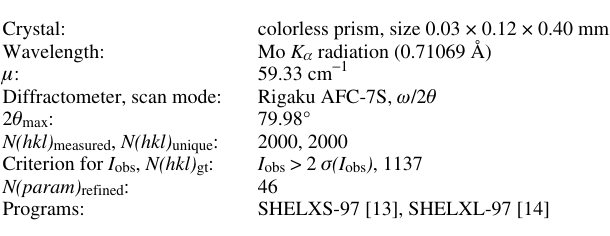
Table 1. Data collection and handling.